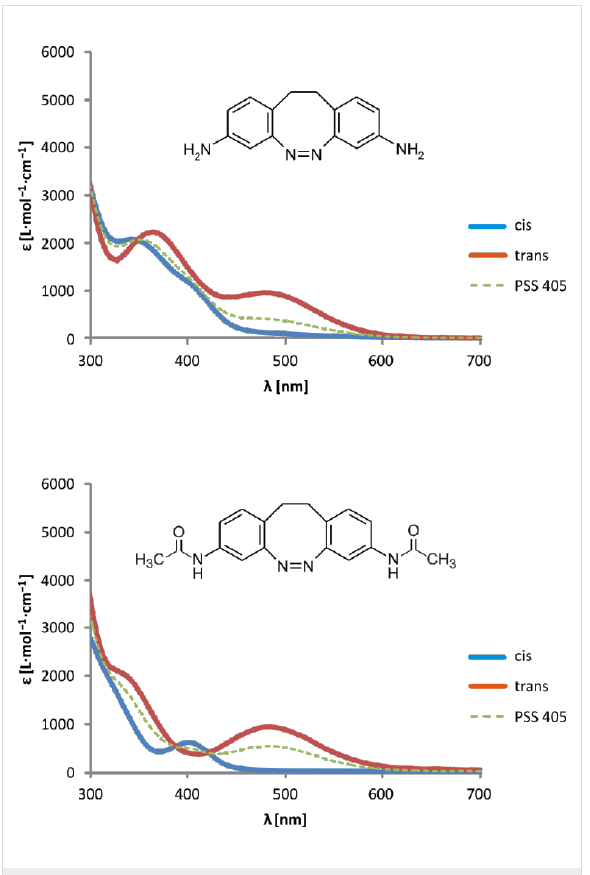
Figure 3: UV–vis spectra of the diazocine derivatives 3,3’-diamino- EBAB 4 and its bisamide derivative 5 in acetonitrile.